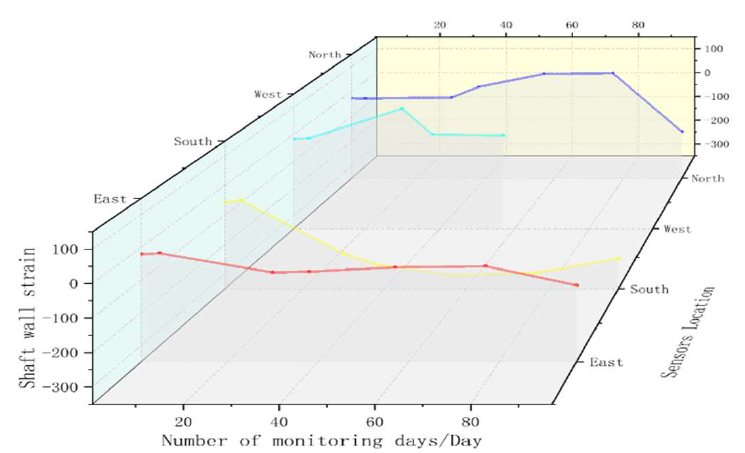
Figure 11. Vibrating-string sensing strain diagram (581 m).